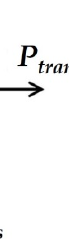
Figure 29. Photograph of a measuring stand with a horn measuring cell.